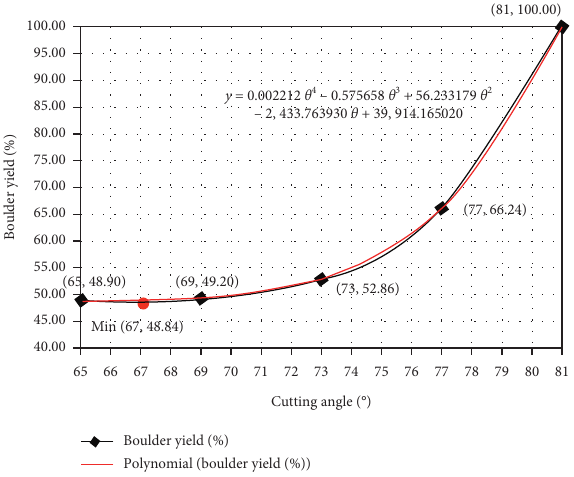
Figure 19: The trend of wedge cutting model and the bulk rate at different angles. Table 8: Error analysis table of blasting fragment fitting formula. Cutting